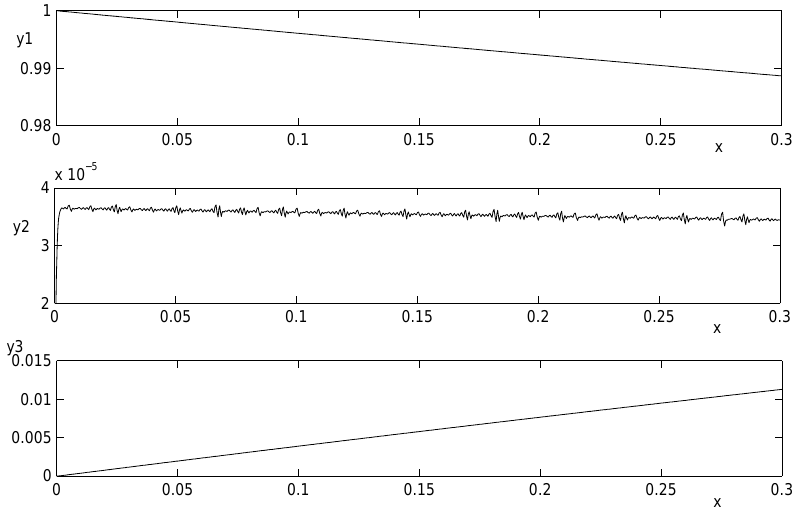
Figure 3. Solution of the Robertson’s problem (4.4) obtained with the aid of the program ODE45.